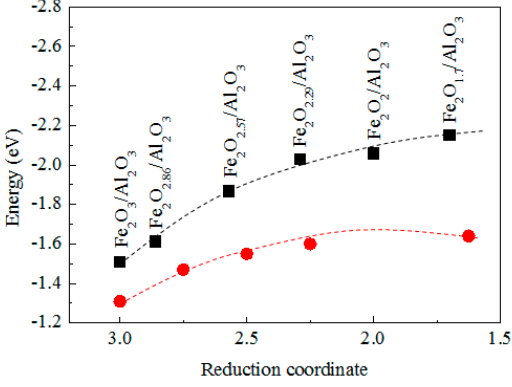
Figure 13. The adsorption energy of CO on the pure and reduced Fe 2 O 3 /Al 2 O.